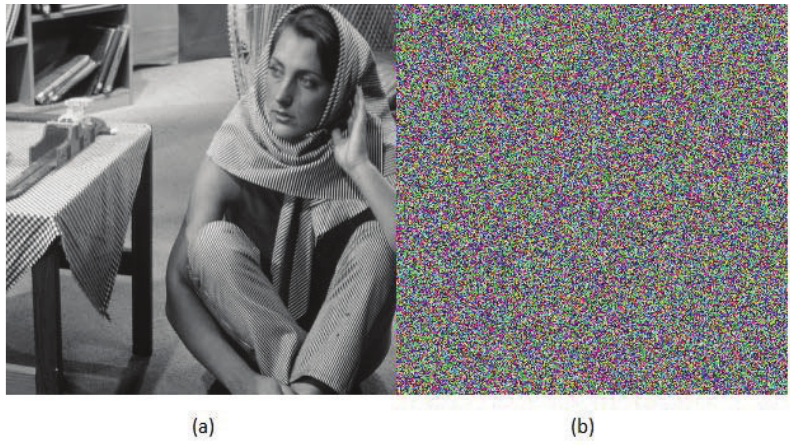
Figure 3. Barbara image ( a ) original and ( b ) ciphered with